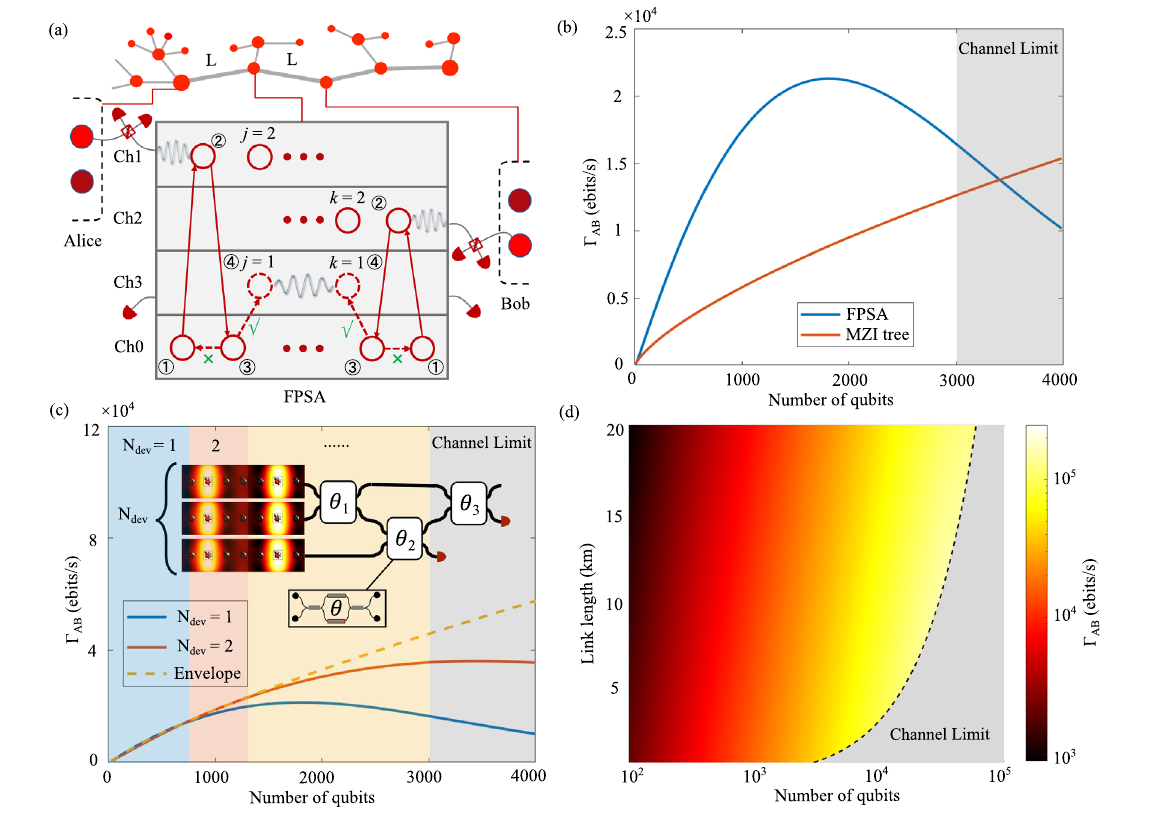
Fig. 4 | Quantum repeater performance. a Quantum repeater architecture con- taining quantum nodes (red) connected by channels (gray). Detectors are for dis- tant and local Bell state measurement. Here we consider a 3-node link containing Alice, Bob and a central FPSA. NVs are Stark-shifted to frequency channels (Ch0- Ch3)atdifferentpointsintheprotocolindicatedbystep1-4.Step1:NVpreparation, which contains optical phase stabilization and NV charge/resonance state check. Step 2: Stark shift is applied to set NV optical transition to a spectral channel that communicateswiththedistantlink,andaheraldedsinglephotonschemeisapplied to generate entanglement. Step 3: Stark shift is applied to set the NV transition